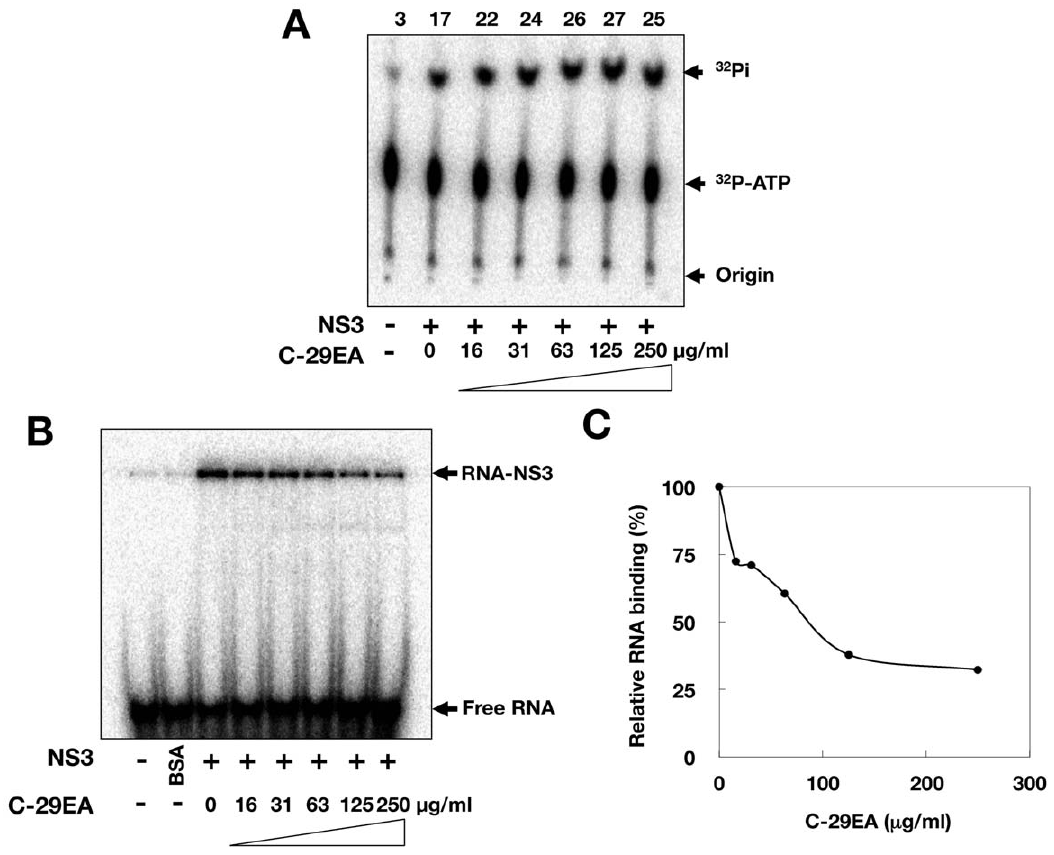
Figure 6. Effect of C-29EA on ATPase and RNA-binding activities of NS3 helicase. (A) The reaction mixtures were incubated with [ c - 32 P] ATP as described in Materials and Methods. The reaction mixtures were subjected to thin-layer chromatography. The start positions and migrated positions of ATP and free phosphoric acid are indicated as ‘Origin’, ‘ 32 P-ATP’, and ‘ 32 P-Pi’, respectively, on the right side of the figure. The data represent three independent experiments. Treatment with DMSO corresponds to ‘0 9 . (B) Gel mobility shift assay for RNA-binding activity of NS3 helicase. The reaction was carried out with 0.5 nM labeled ssRNA at the indicated concentrations of C-29EA or DMSO. The reaction mixture was subjected to gel mobility shift assay. (C) The relative RNA-binding ability was calculated with band densities in each lane and presented as a percentage of RNA-NS3 in the total density. The data represent three independent experiments. Treatment with DMSO corresponds to ‘0 9 .